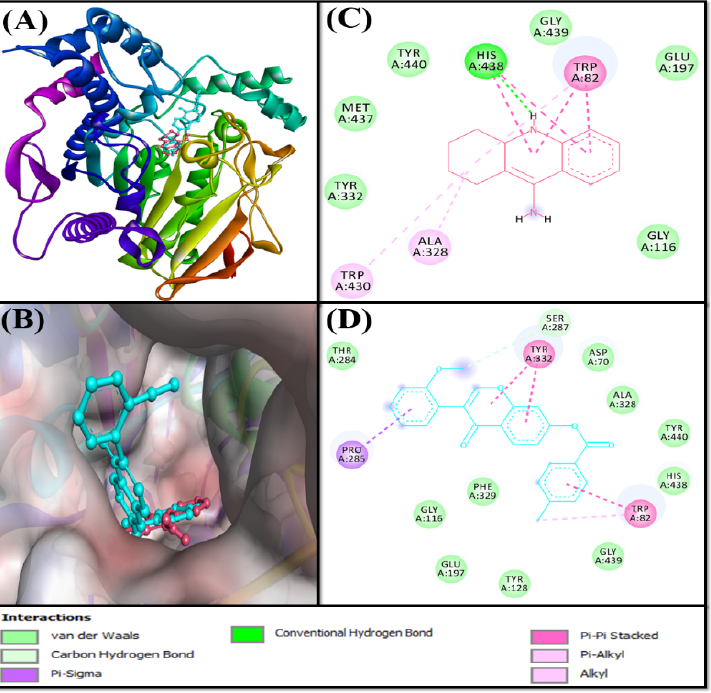
Figure 2. Interaction of target protein, BChE with F0850-4777 and their respective control ligands. ( A ) Position of F0850-4777 and Tacrine in BChE. ( B ) Interactions between BChE and Tacrine ( C ). Superimposed image of F0850-4777 and Tacrine in BChE. ( D ) Interactions between BChE and F0850- 4777.